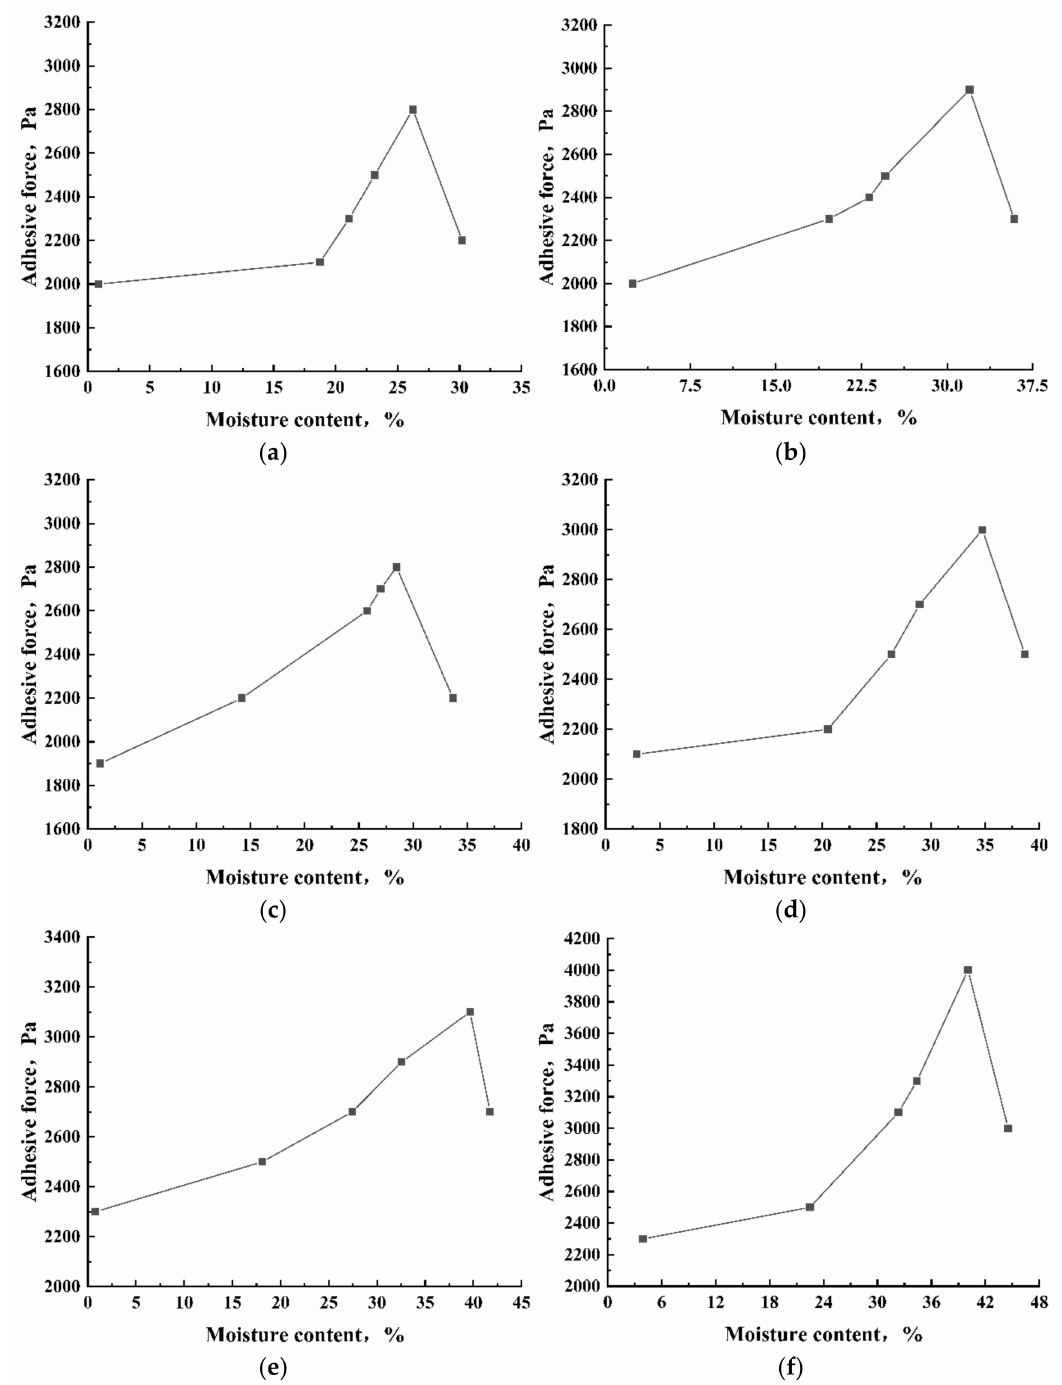
Figure 5. Characteristic curves for adhesive force: ( a ) Lanzhou loess, ( b ) Songling soil, ( c ) Tahe soil, ( d ) Harbin clay, ( e ) loam, ( f ) Genhe red